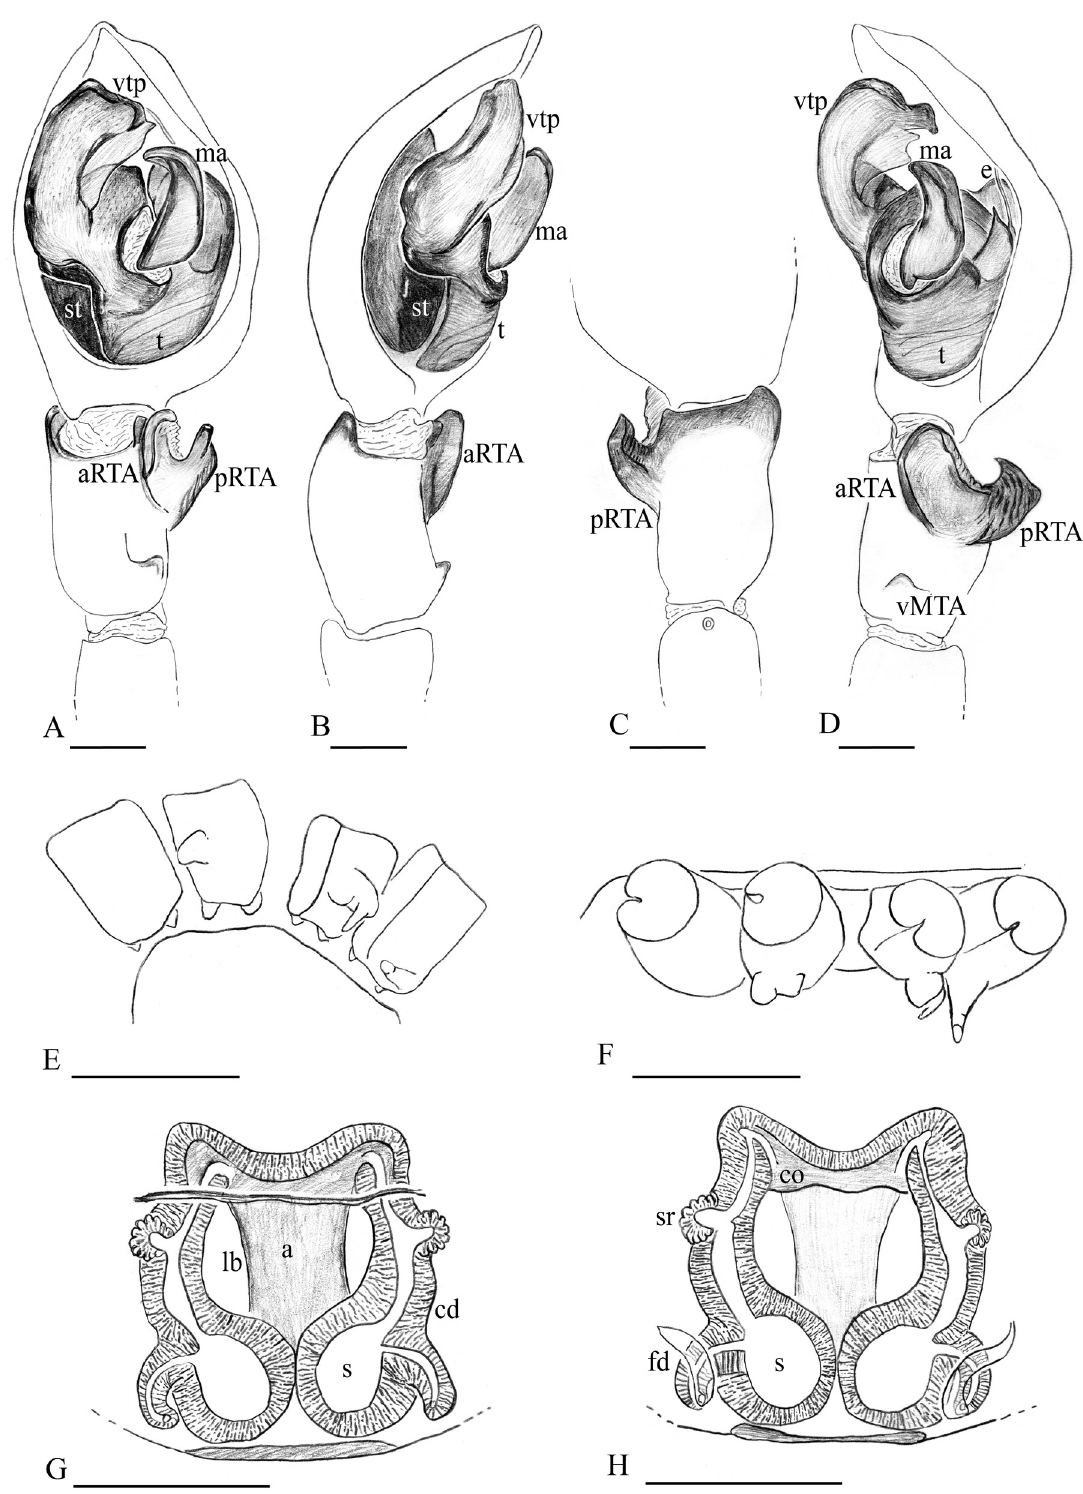
Fig. 30. Anyphaena rebecae sp. nov. A–F . Paratype, ♂ (CNAN-T01568). G –H . Paratype, ♀ (CNAN-T01569). A . Pedipalp, ventral view. B . Pedipalp, prolateral view. C . Pedipalp, dorsal view. D . Pedipalp, retrolateral view. E . Coxae, ventral view. F . Coxae, lateral view. G . Epigynum, ventral view. H . Epigynum, dorsal view. Scale bars: A–D, G–H = 0.2 mm; E–F = 1.0